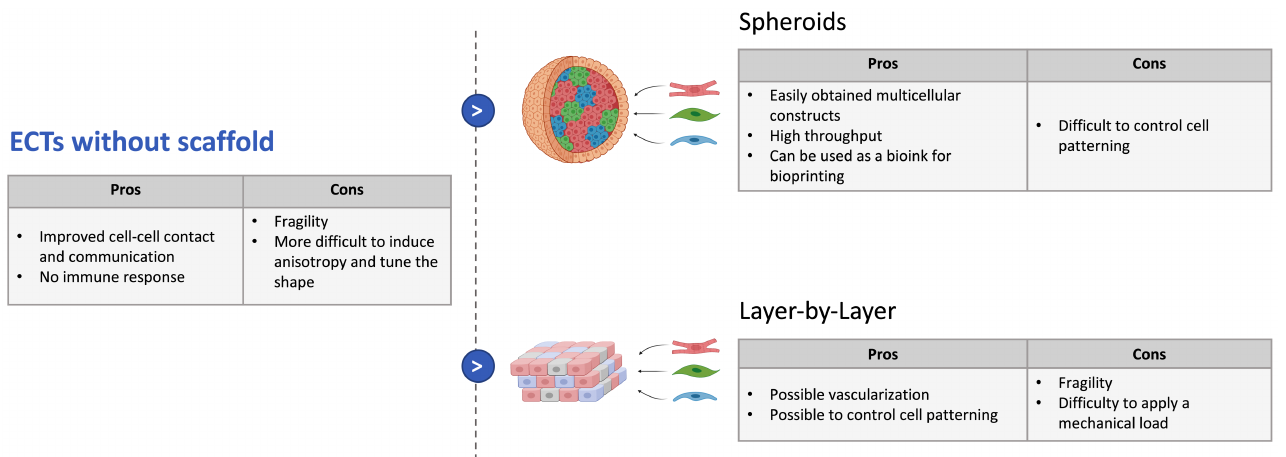
Figure 1. Strategies to build 3D-ECTs without scaffolds, advantages, and